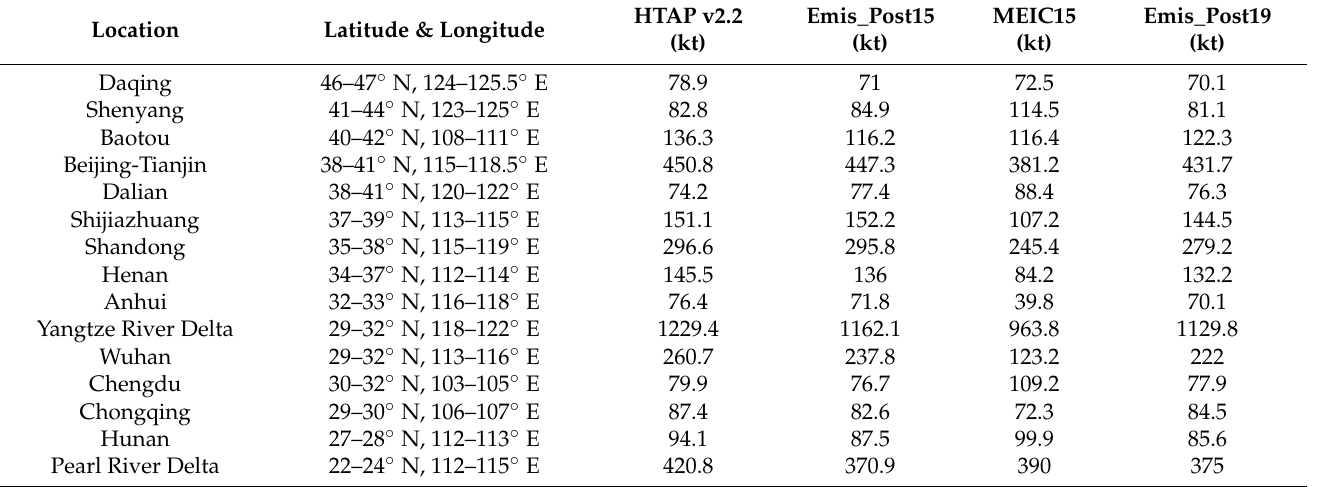
inventories and